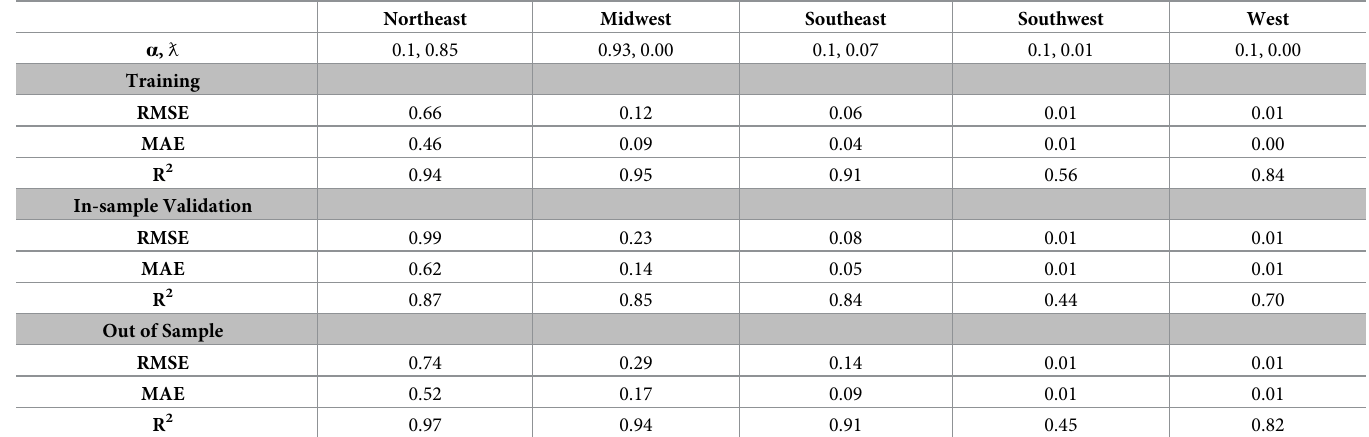
Table 6. Predictions form full-term list models produce highly accurate predictions with low error. Northeast